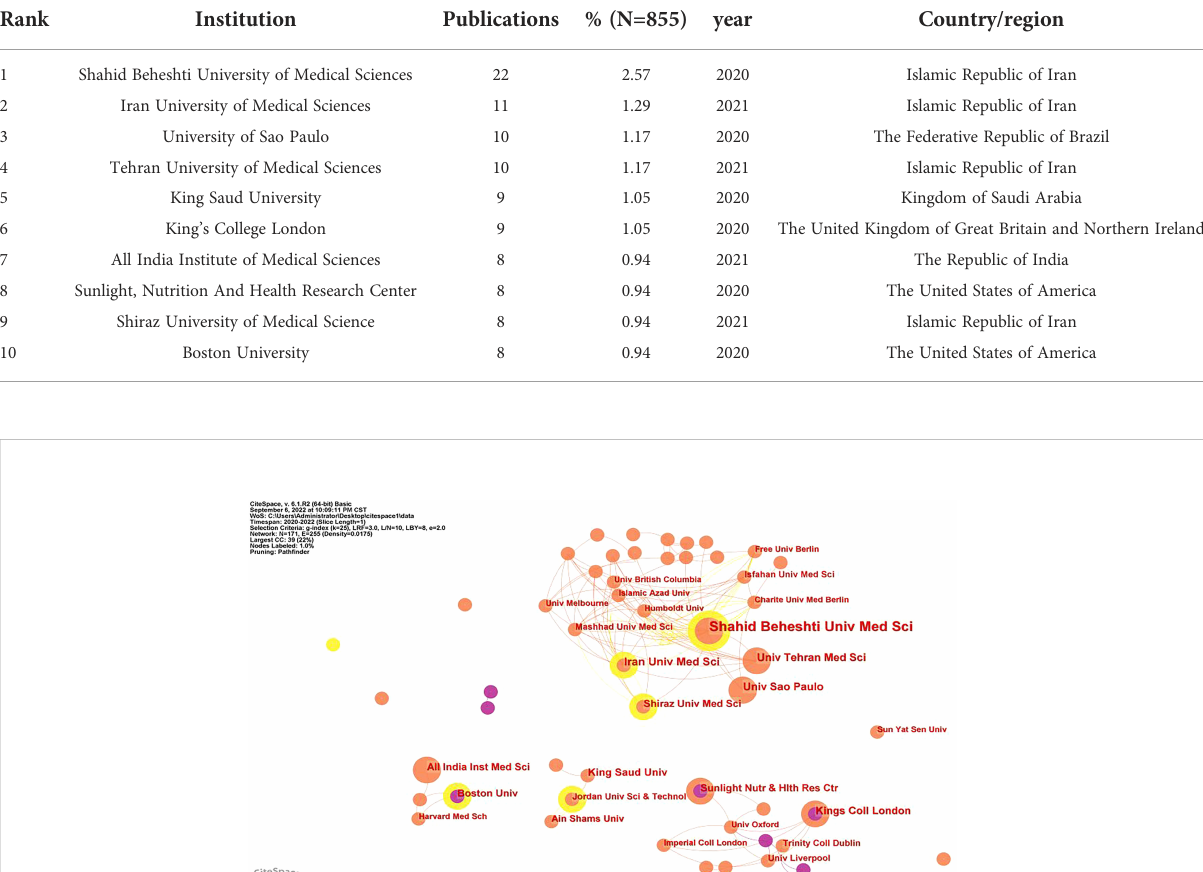
TABLE 6 Top 10 research institutions in the fi eld.